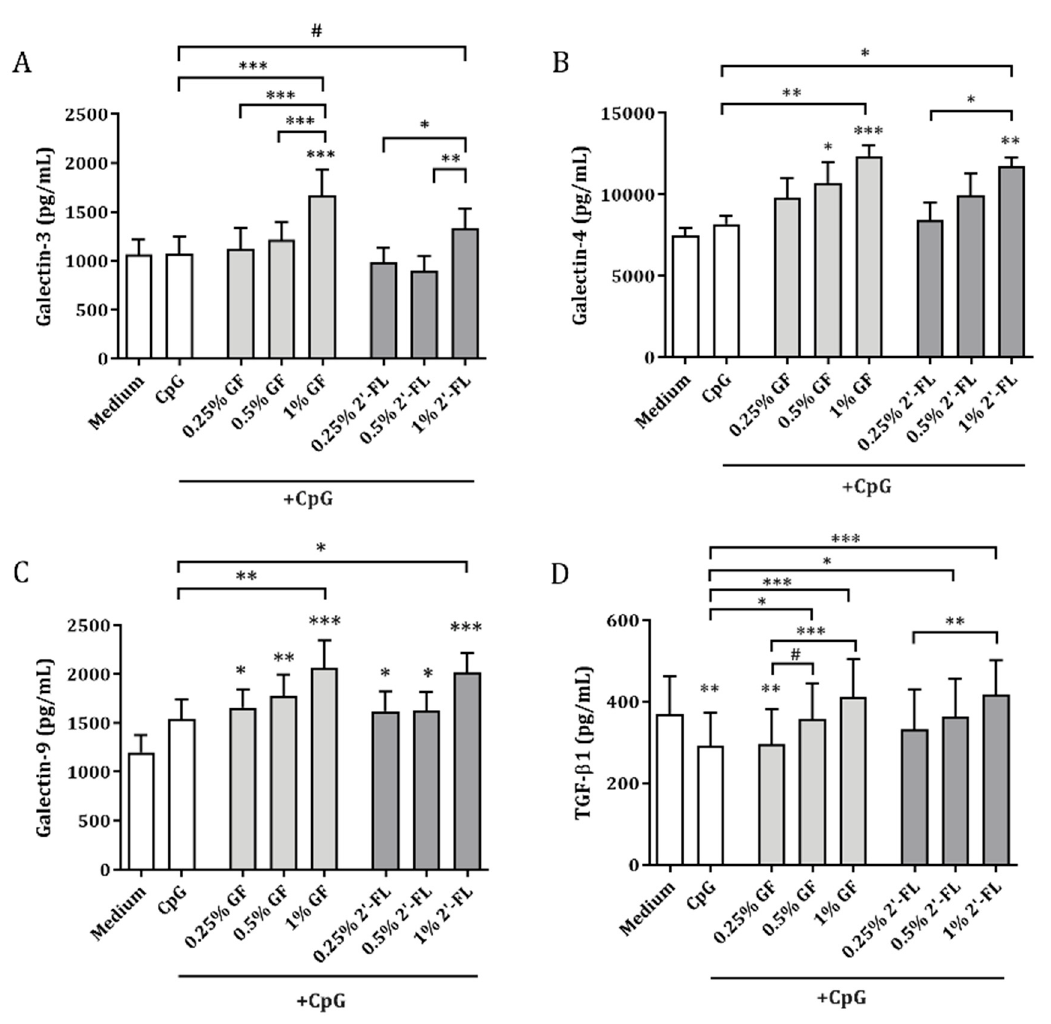
Figure 4. IEC-derived galectins and TGF- β 1 secretion. IEC were washed after IEC / PBMC co-culture and incubated with fresh medium for an additional 24 h (Figure 1B). After the incubation period, IEC-derived galectin-3 ( A ), galectin-4 ( B ), galectin-9 ( C ) and TGF- β 1 ( D ) were measured in the basolateral supernatant. Data are represented as mean ± SEM of 6–8 independent PBMC donors (# p < 0.1,* p < 0.05, ** p < 0.01, *** p < 0.001).